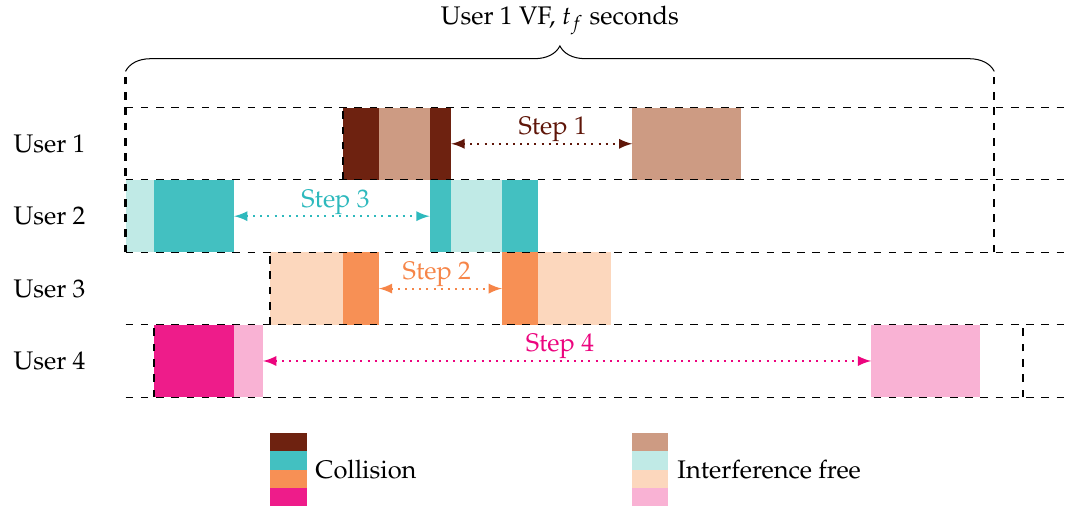
Figure 1. Example of the collision pattern at the receiver and of the SIC procedure. Upon correct decoding, SIC removes the packet and its